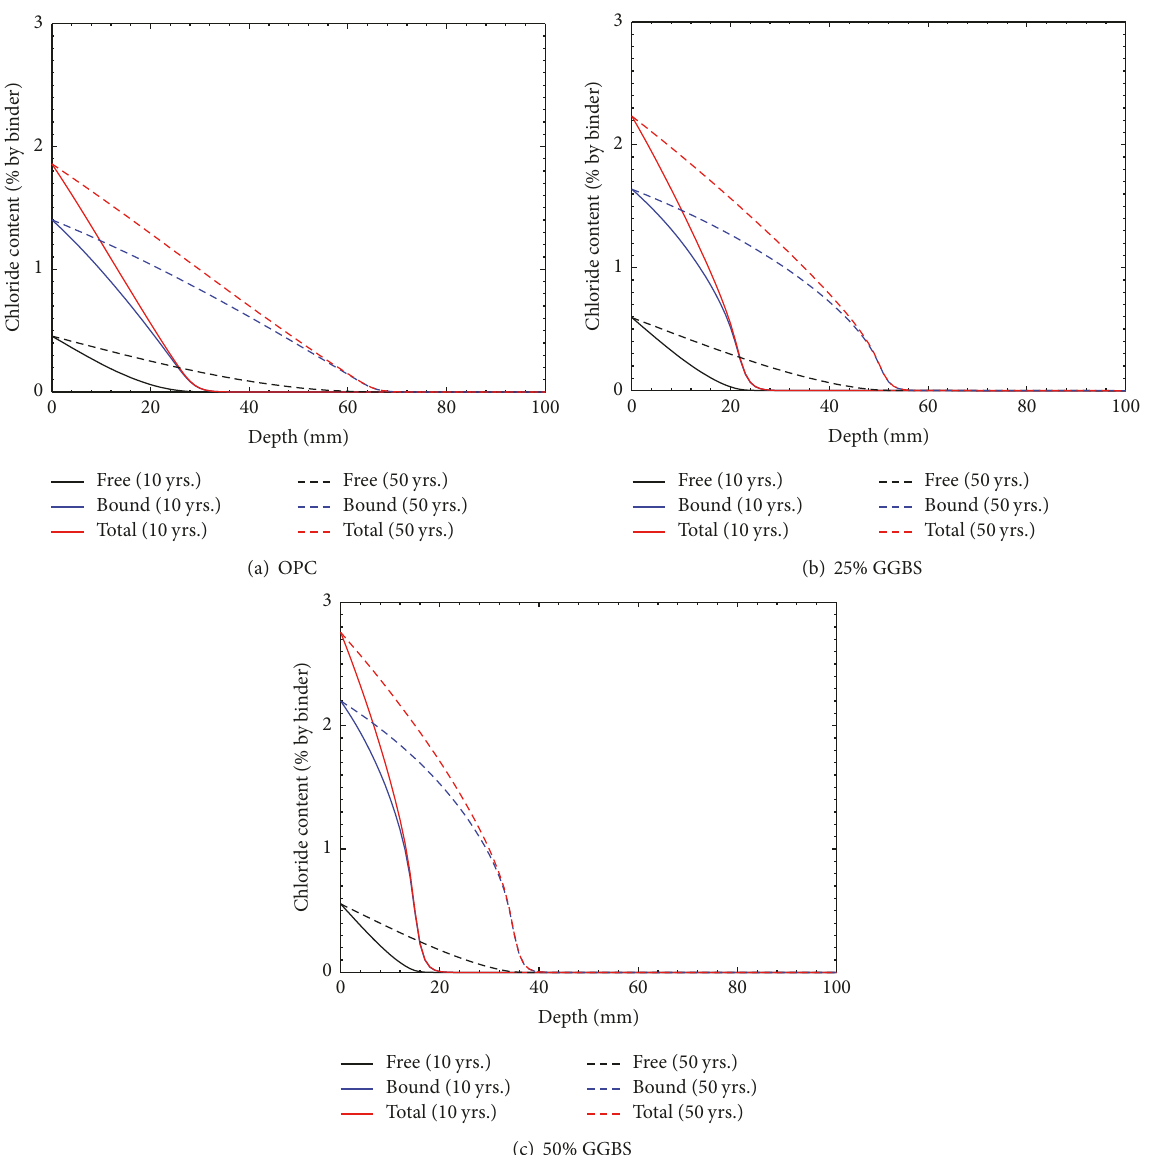
Figure 3: Prediction of concentrations for free, bound, and total chlorides at 10 and 50